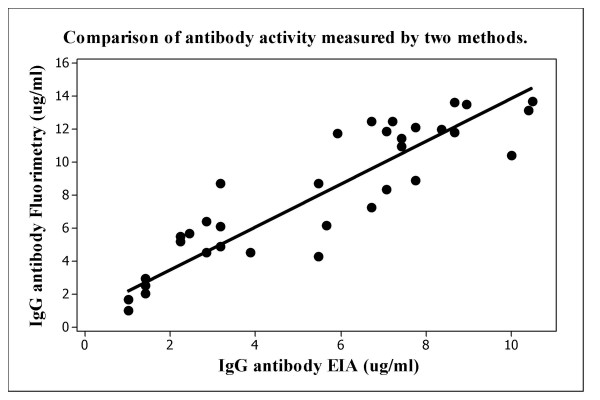
Comparison of the concentrations of serum IgG antibody [ug/ml] against pigeon serum antigens quantified by both in-house enzyme immunoassay [EIA] and by automated fluorimetry in 50 pigeon fanciers. A transformed (square root) scale has been used on both axes.